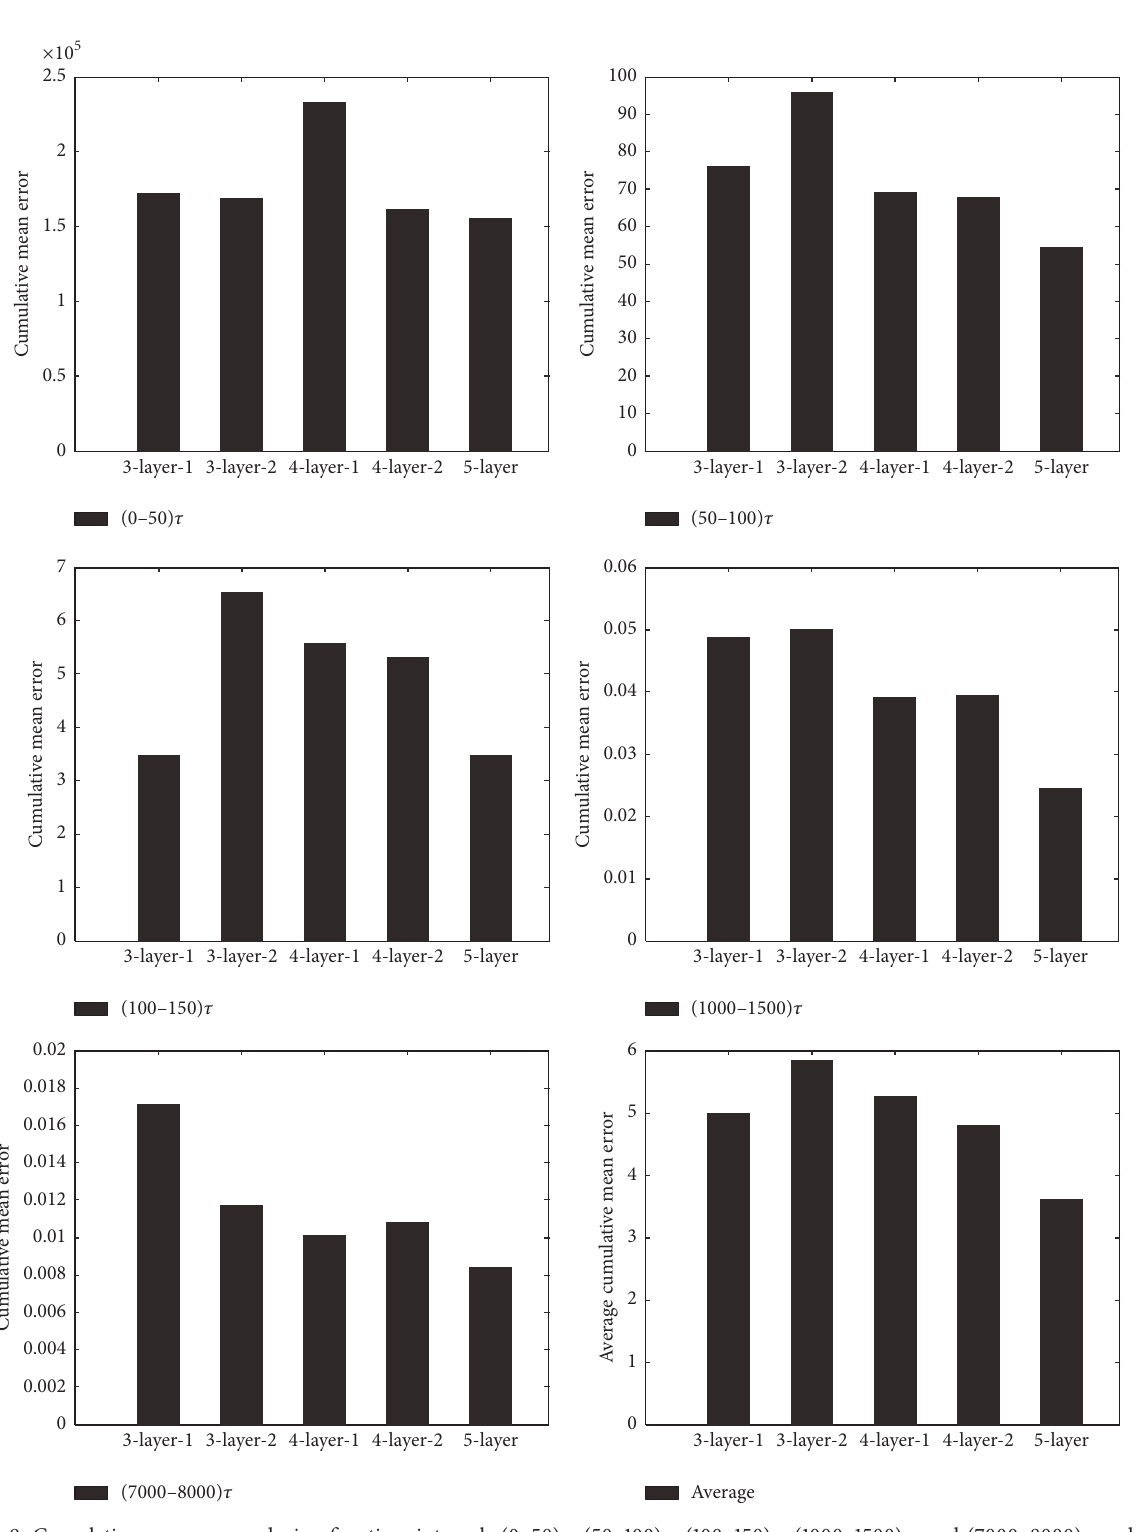
Figure 9: Cumulative mean errors during five time intervals (0–50) 𝜏 , (50–100) 𝜏 , (100–150) 𝜏 , (1000–1500) 𝜏 , and (7000–8000) 𝜏 and final average